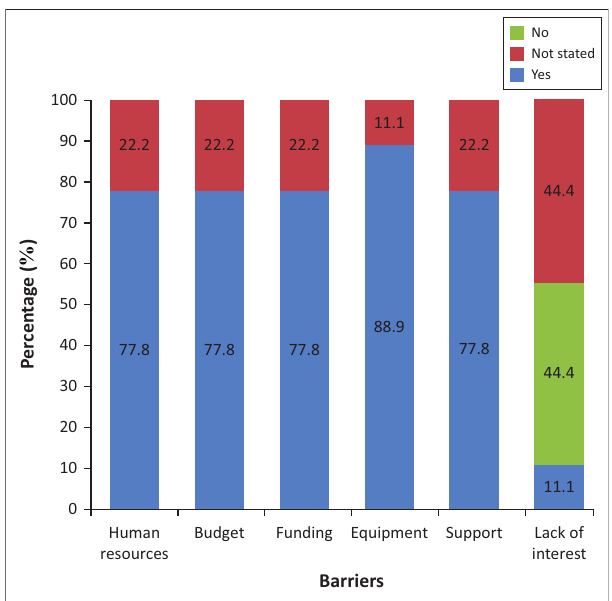
FIGURE 12: Percentage distributions on existing barriers to implementing a diabetic eye screening